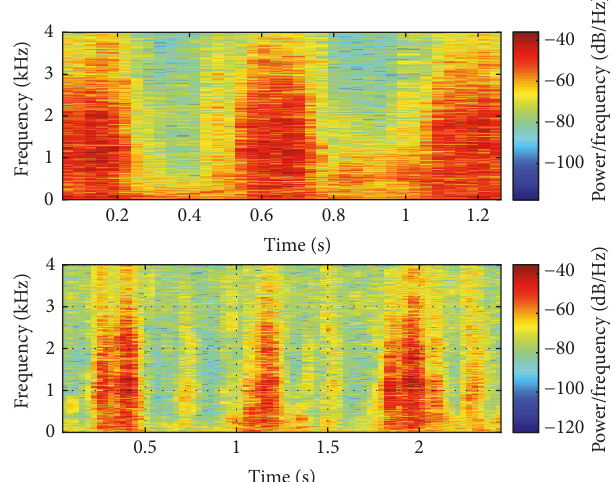
Figure 4: Typical audio spectrogram data. Representative spectrogram graphs demonstrating a reduction in high amplitude signal across all frequencies, especially in the high frequency range after